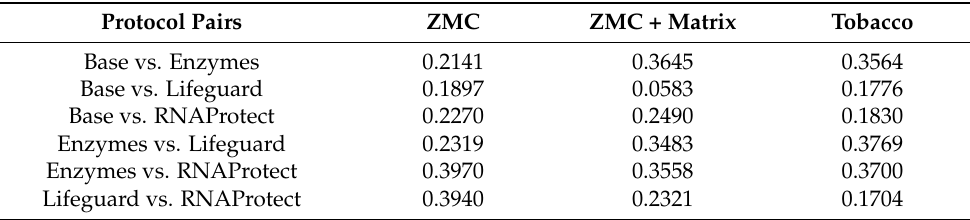
Table 4. Scaled pairwise Euclidean distances (divided by their Frobenius norms) between four extraction protocols for ZMC, ZMC + Matrix and tobacco